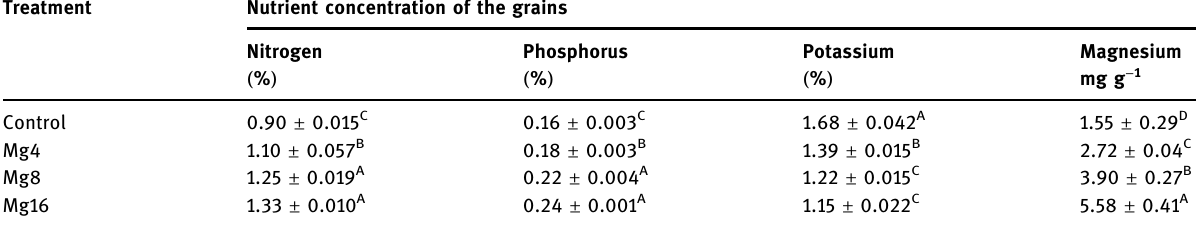
Table 3: Maize grains and shoot nutrients concentration under various levels of Mg in calcareous soils Treatment